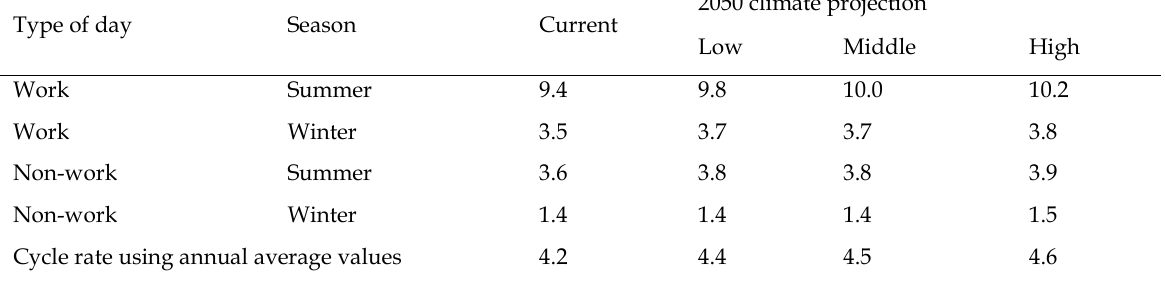
Table 5. Daily cycle rate predicted by the